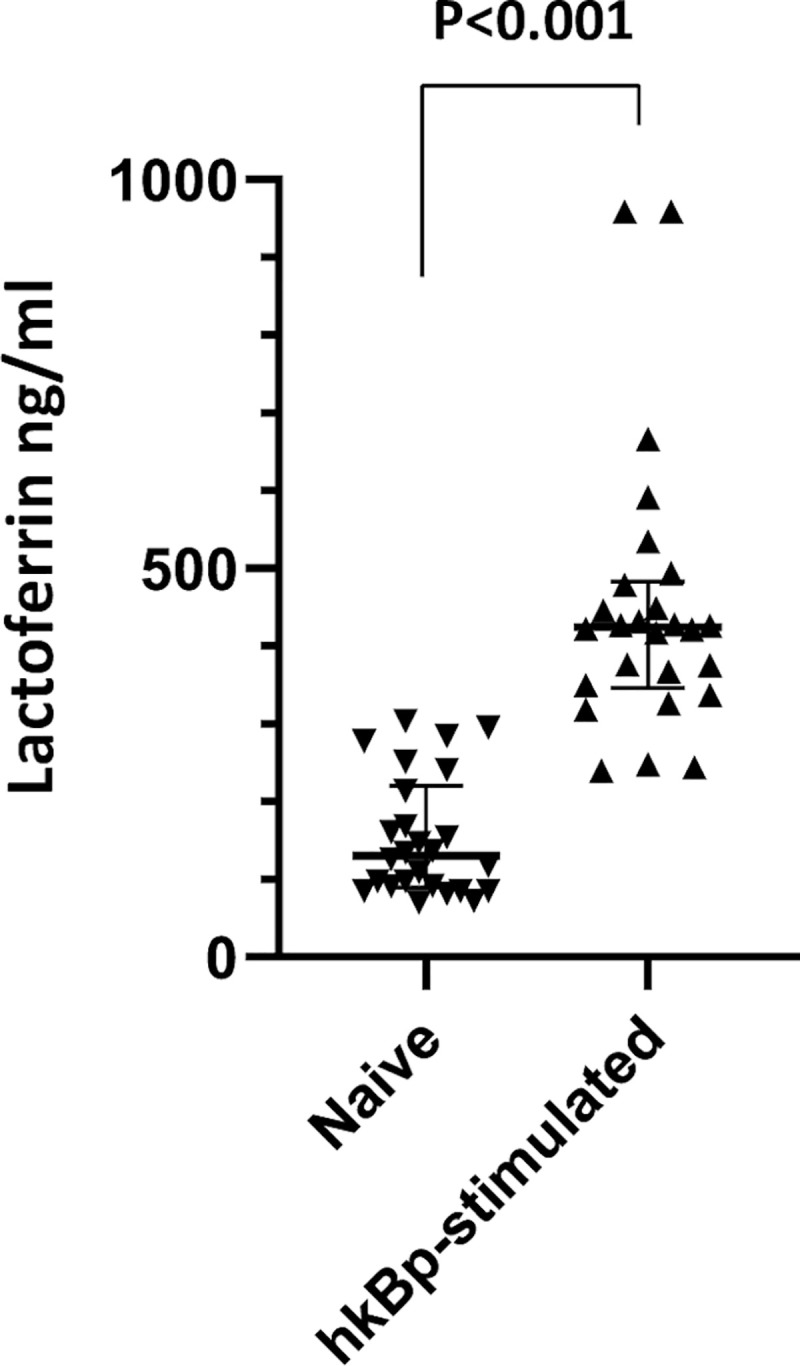
Lactoferrin is produced by blood cells of healthy individuals after stimulation with Bp.Plasma lactoferrin concentrations of matched, unstimulated (naïve) blood from healthy individuals and blood stimulated with heat-killed Bp K96243 (hkBp) at 2.5 x 106 CFU/ml (N = 26). Data presented as individual values with median and IQR. Comparisons are made following log10-transformation of data using paired t-test.